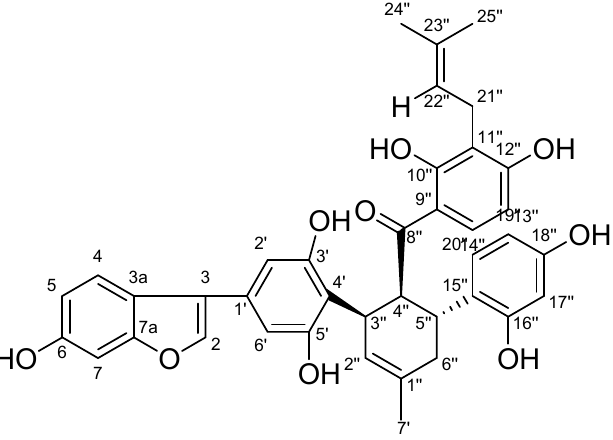
Figure 1. Chemical structure formula of chalcomoracin.